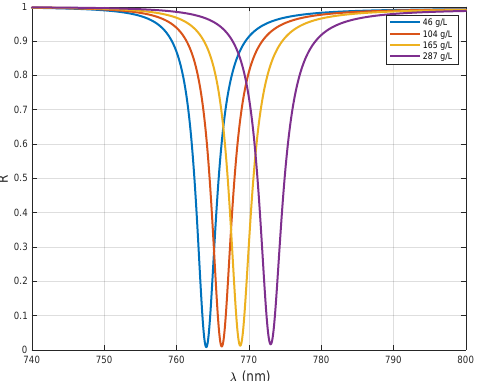
Figure 4. Reflectance spectra of the sensor for different hemoglobin